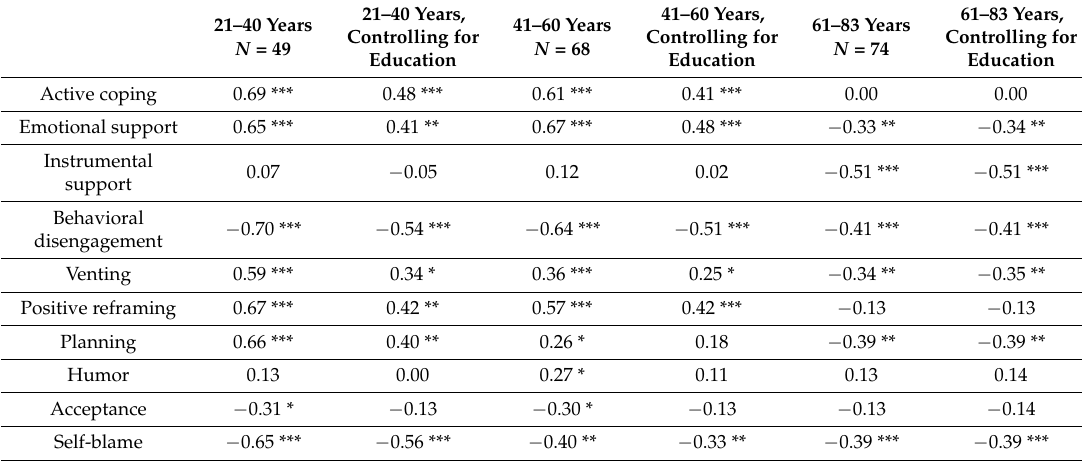
Table 2. Correlations between SOC and use of different coping strategies among the three age groups when we controlled for education.